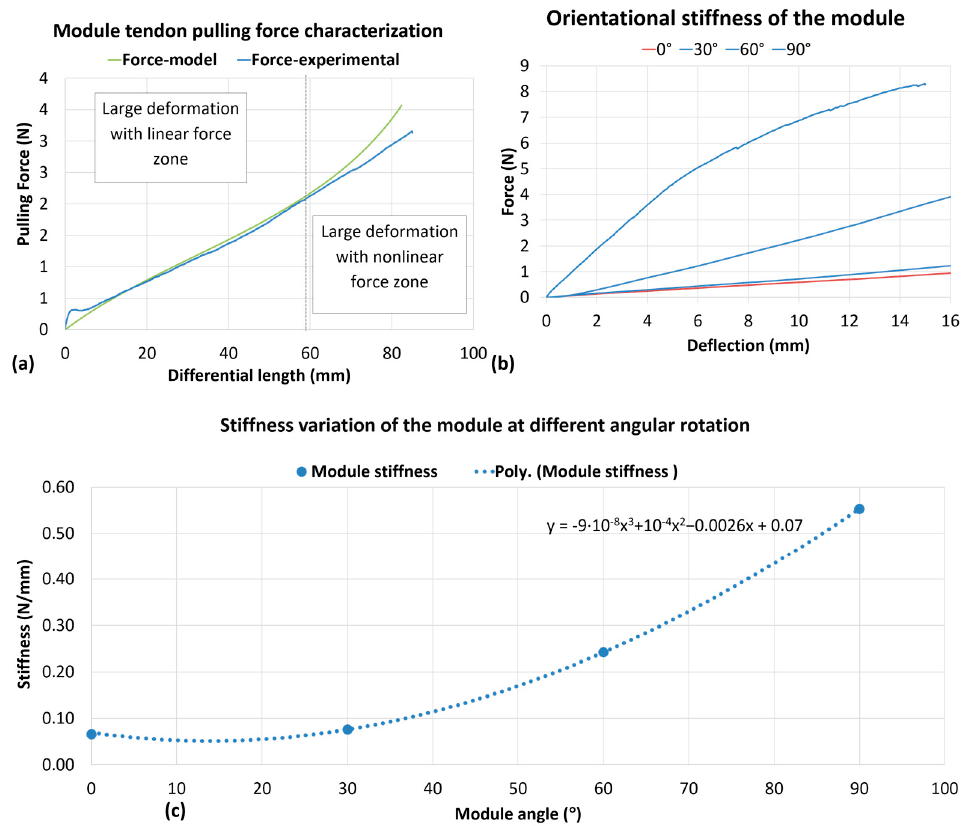
Figure 12. Force and stiffness characterization of the module at different angles. ( a ) Tendon pulling force and model prediction; ( b ) measurement of bending force; ( c ) module stiffness behavior as a function of module positional angle with polynomial fitting. Poly: Third order polynomials.